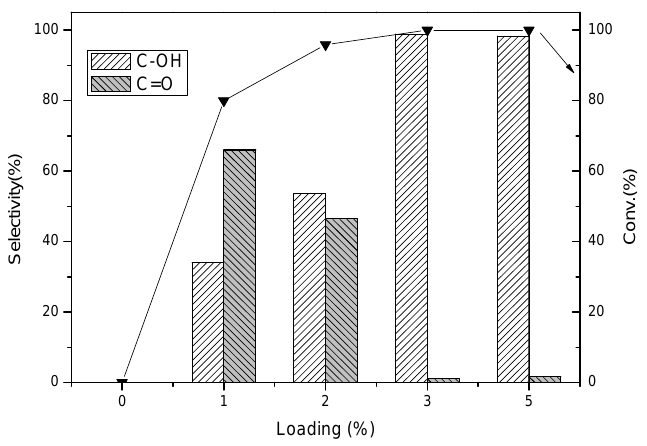
Figure 4. Effect of Pd loading on the hydrogenation of 4-ethylphenol. Reaction conditions: 25 mL H 2 O, 0.82 mmol 4-ethylphenol, 0.20g Pd/ γ -Al 2 O 3 , 2 MPa H 2 , 12 h, 60 °C.